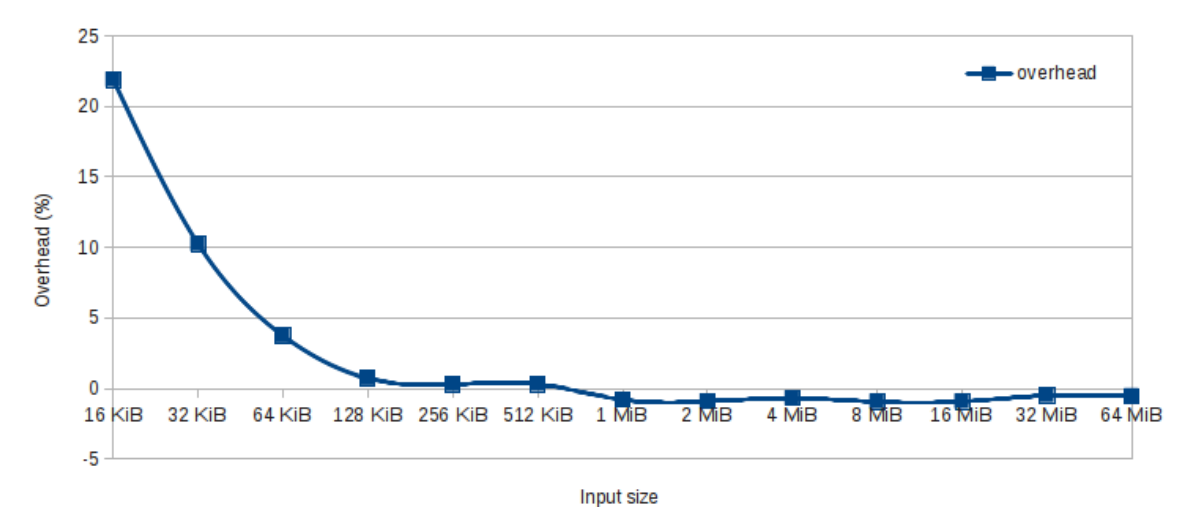
Figure 5. Salus’ performance overhead on the gzip macro benchmark drops significantly as the input file size